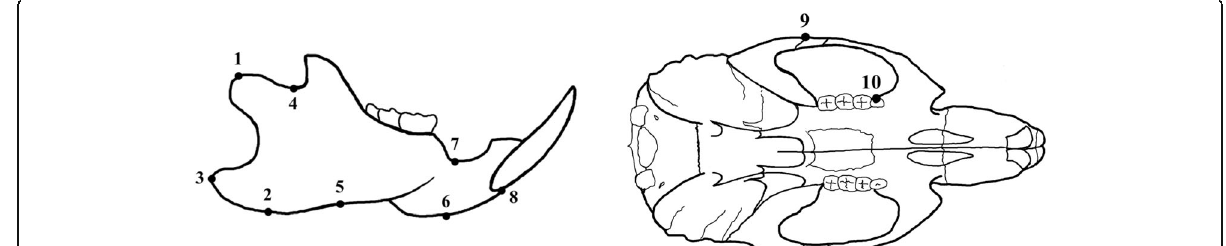
Fig. 1 Anthropometric measurement points. (1) Condylion (Cd): most posterior and superior points on the mandibular condyle. (2) Gnathion (Gn): most inferior point of the bony contour of the mandible gonial angle. (3) Gonion (Go): most posterior point of the bony contour of the mandible gonial angle. (4) Coronoid notch (Co): most inferior and concave point of the coronoid notch. (5) Antegonial notch: most superior point of the curvature of the antegonial notch. (6) Menton (Me): most inferior point of the mandibular symphysis. (7) Mandibular alveolar point: most inferior point on the mandibular alveolar crest. (8) Infradentale: most superior and anterior point of the mandibular alveolar bone between the lower central incisors. (9) Zygion (Zy): most external point of the zygomatic arch. (10) Maxillary point (key ridge): most inferior point on the zygomatic process of the maxilla